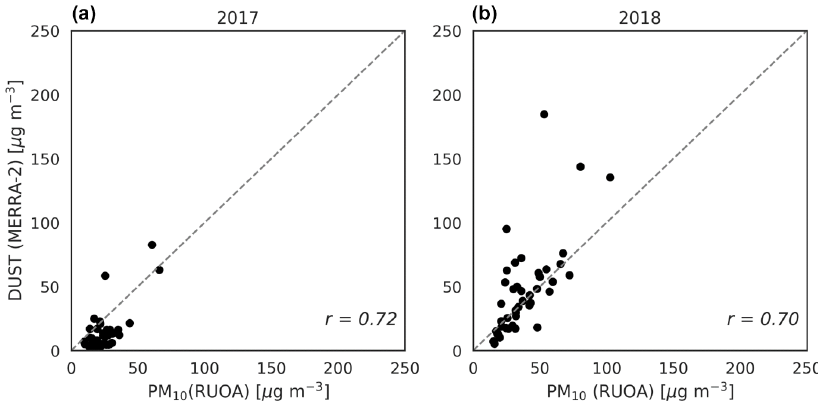
Figure 6. Dispersion diagrams of the surface dust mixing ratio from MERRA-2 ( y axis) vs. the PM 10 from the RUOA station for the periods shown in Fig. 5 for (a) 2017 and (b)